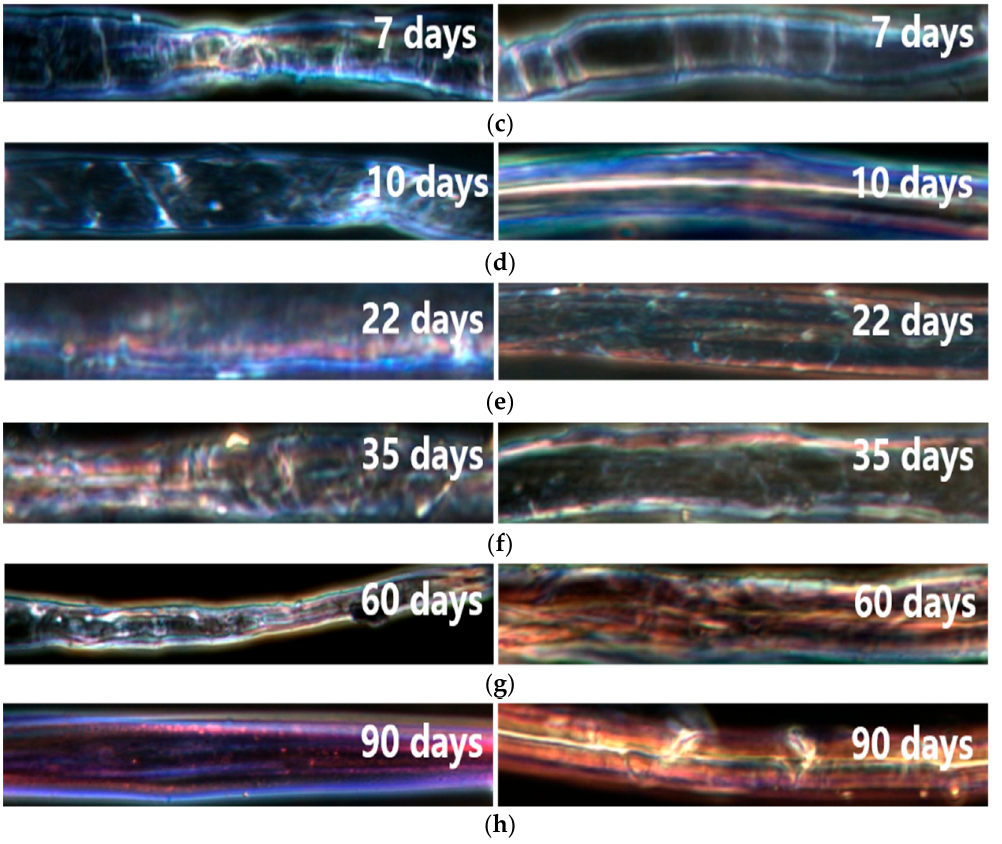
Figure 4. Typical chromatic dispersion color of fibers in oil at different aging stages. ( a ) 0 days for aging; ( b ) 4 days for aging; ( c ) 7 days for aging; ( d ) 10 days for aging; ( e ) 22 days for aging; ( f ) 35 days for aging; ( g ) 60 days for aging; ( h ) 90 days for aging.